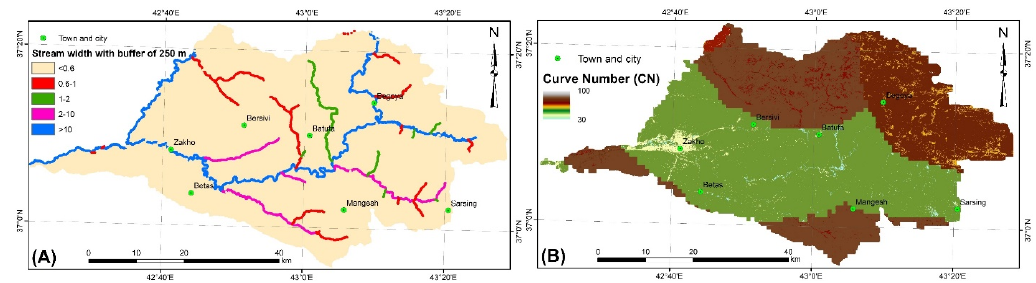
Figure 9. Maps of ( A ) stream width map, and ( B ) Curve Number (CN) of the study area.